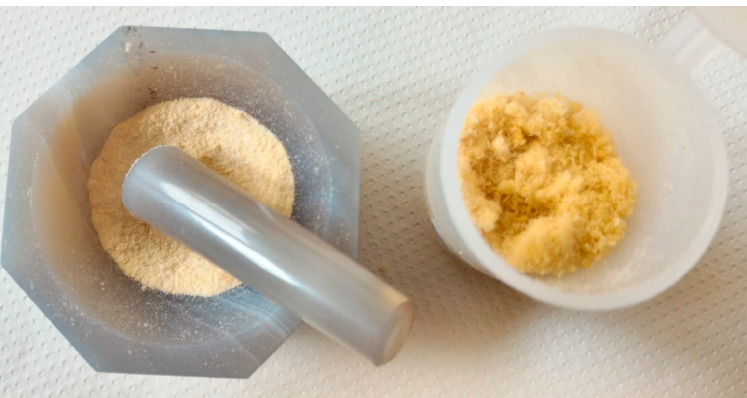
Figure 4. Sample of lyophilized pectin powder from the WOP1 test (right), which was ground in a quartz mortar (left) prior to the diffuse reflectance infrared Fourier transform (DRIFT) experiments.